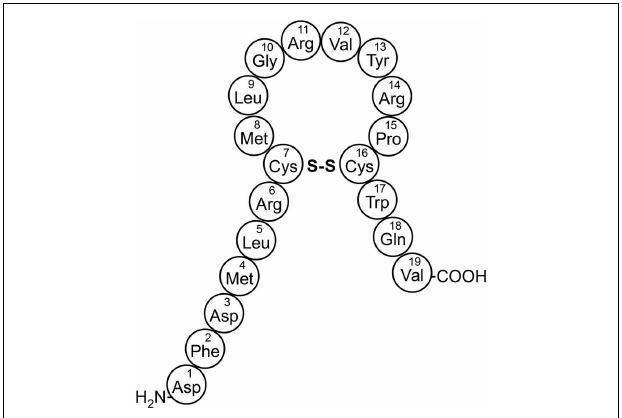
FIGURE 1 |The amino acid structure of mammalian